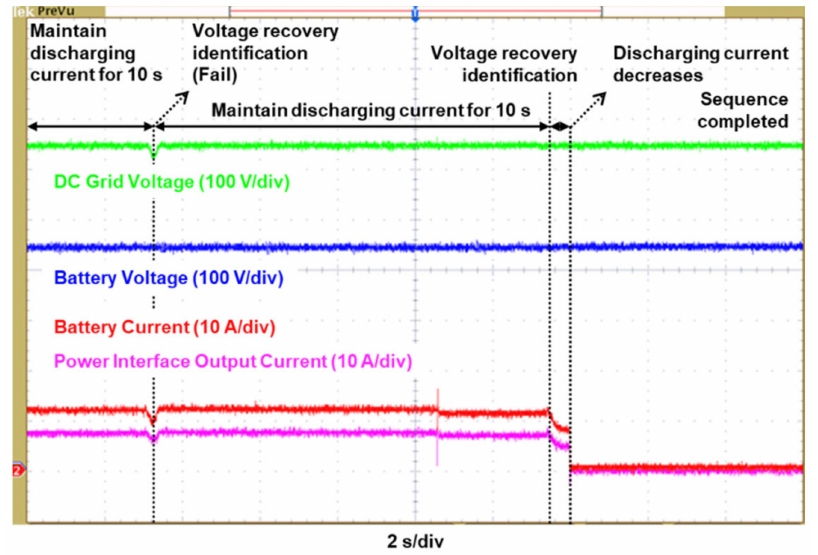
Figure 16. Completion sequence of proposed voltage regulation algorithm at undervoltage